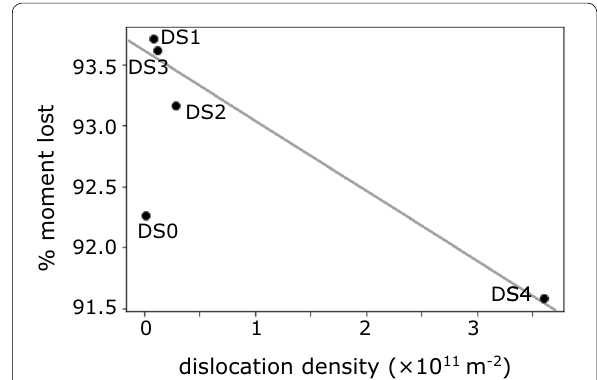
Fig. 5 Percent of net magnetic moment lost after cooling through the Verwey transition and warming back to room temperature versus dislocation density. Moment lost calculated from RTSIRM measurements. The trend line is defined by the equation: %moment lost = − 5.6 × 10 − 12 ρ + 94 , where ρ is the dislocation density in 1/ m 2 . DS0 was not included in the trend line calculation